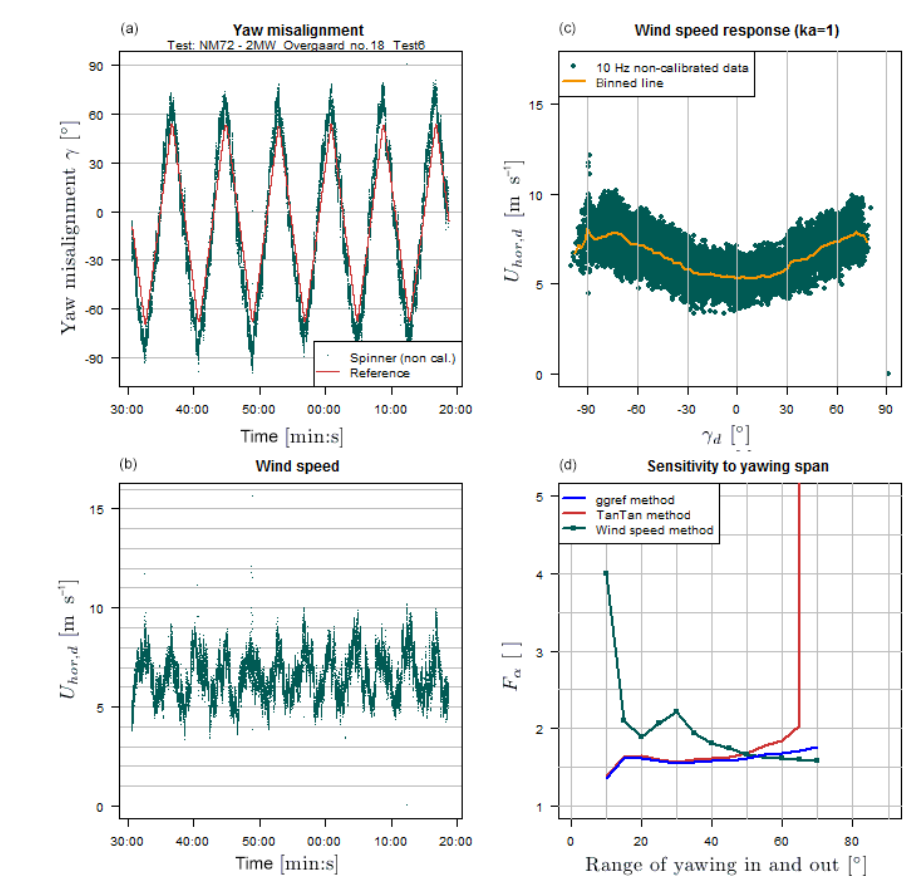
Figure 3. Before calibration, test 6. (a) Time series of yaw misalignment as measured by the spinner anemometer and by the yaw position sensor. (b) Wind speed time series as measured by the spinner anemometer before F 1 calibration. (c) Wind speed as a function of yaw misalignment measured by spinner anemometer. (d) Calibration correction factor F α calculated in three different methods as a function of yawing span ranging from ± 10 to ± 90 ◦ in steps of ± 5 ◦